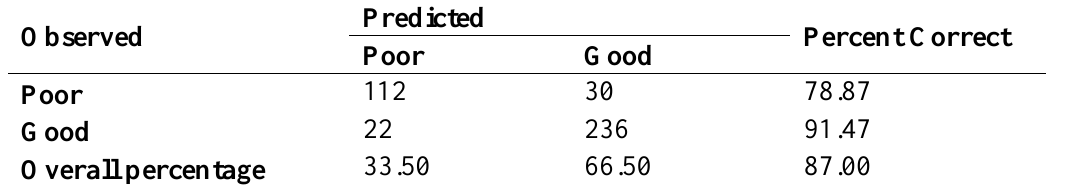
Table 6. Classification results using the second level of riding quality model (binary logit